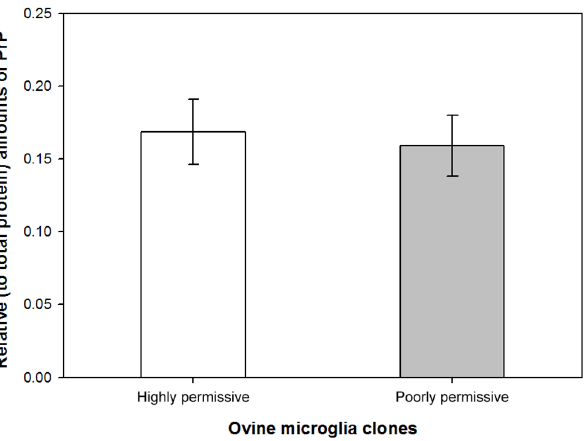
Fig 2. PrP C expression in ovine microglia clones. Cell lysates of uninoculated cells were normalized to total protein and used to quantitatively analyze expression levels of endogenous PrP C by ELISA. No significant difference in PrP C levels was found ( P = 0.573, paired t